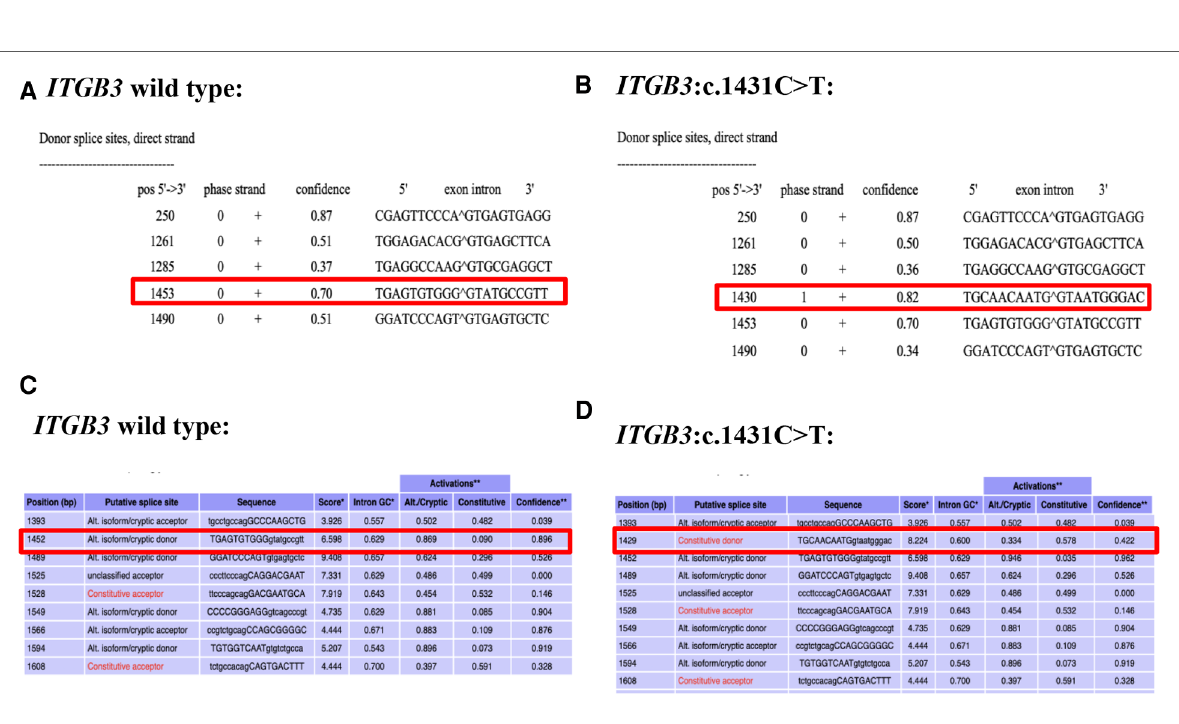
FIGURE 2 Predict results of the c.1431C >T variant site. ( A ) The predict result of wild type ITGB3 by using NetGene2 Server (the red square represented). ( B ) The predict result of ITGB3 : c.1431C>T by using NetGene2 Server (the red square represented). ( C ) The predict result of wild type ITGB3 by using ASSP (the red square represented). ( D ) The predict result of ITGB3 : c.1431C>T by using ASSP (the red square